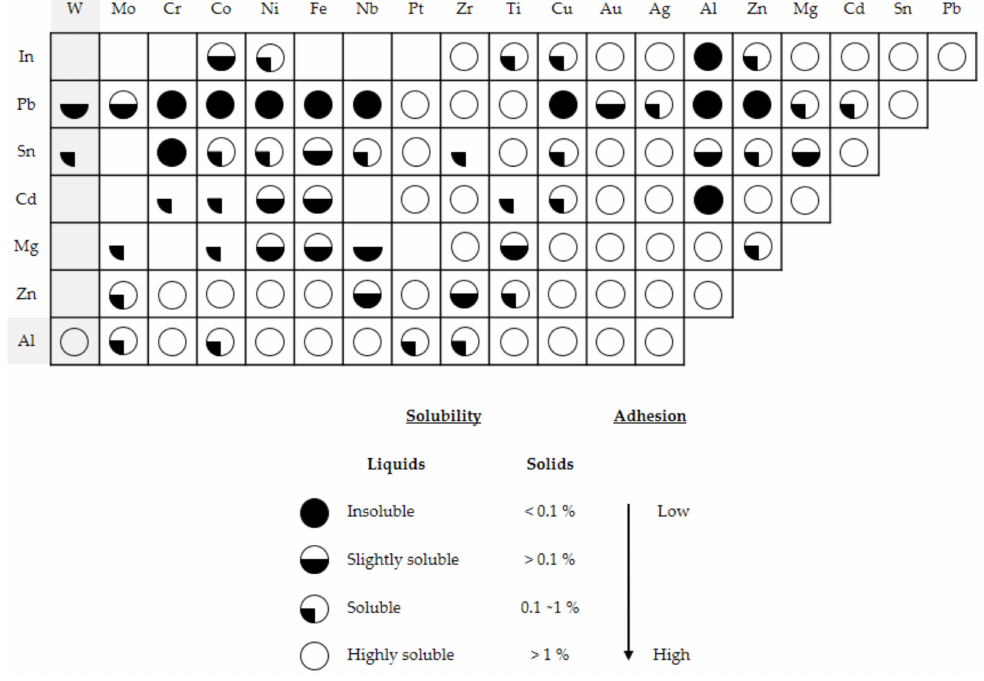
Figure 11. Partial reproduction of the Rabinowicz’s table (adapted from